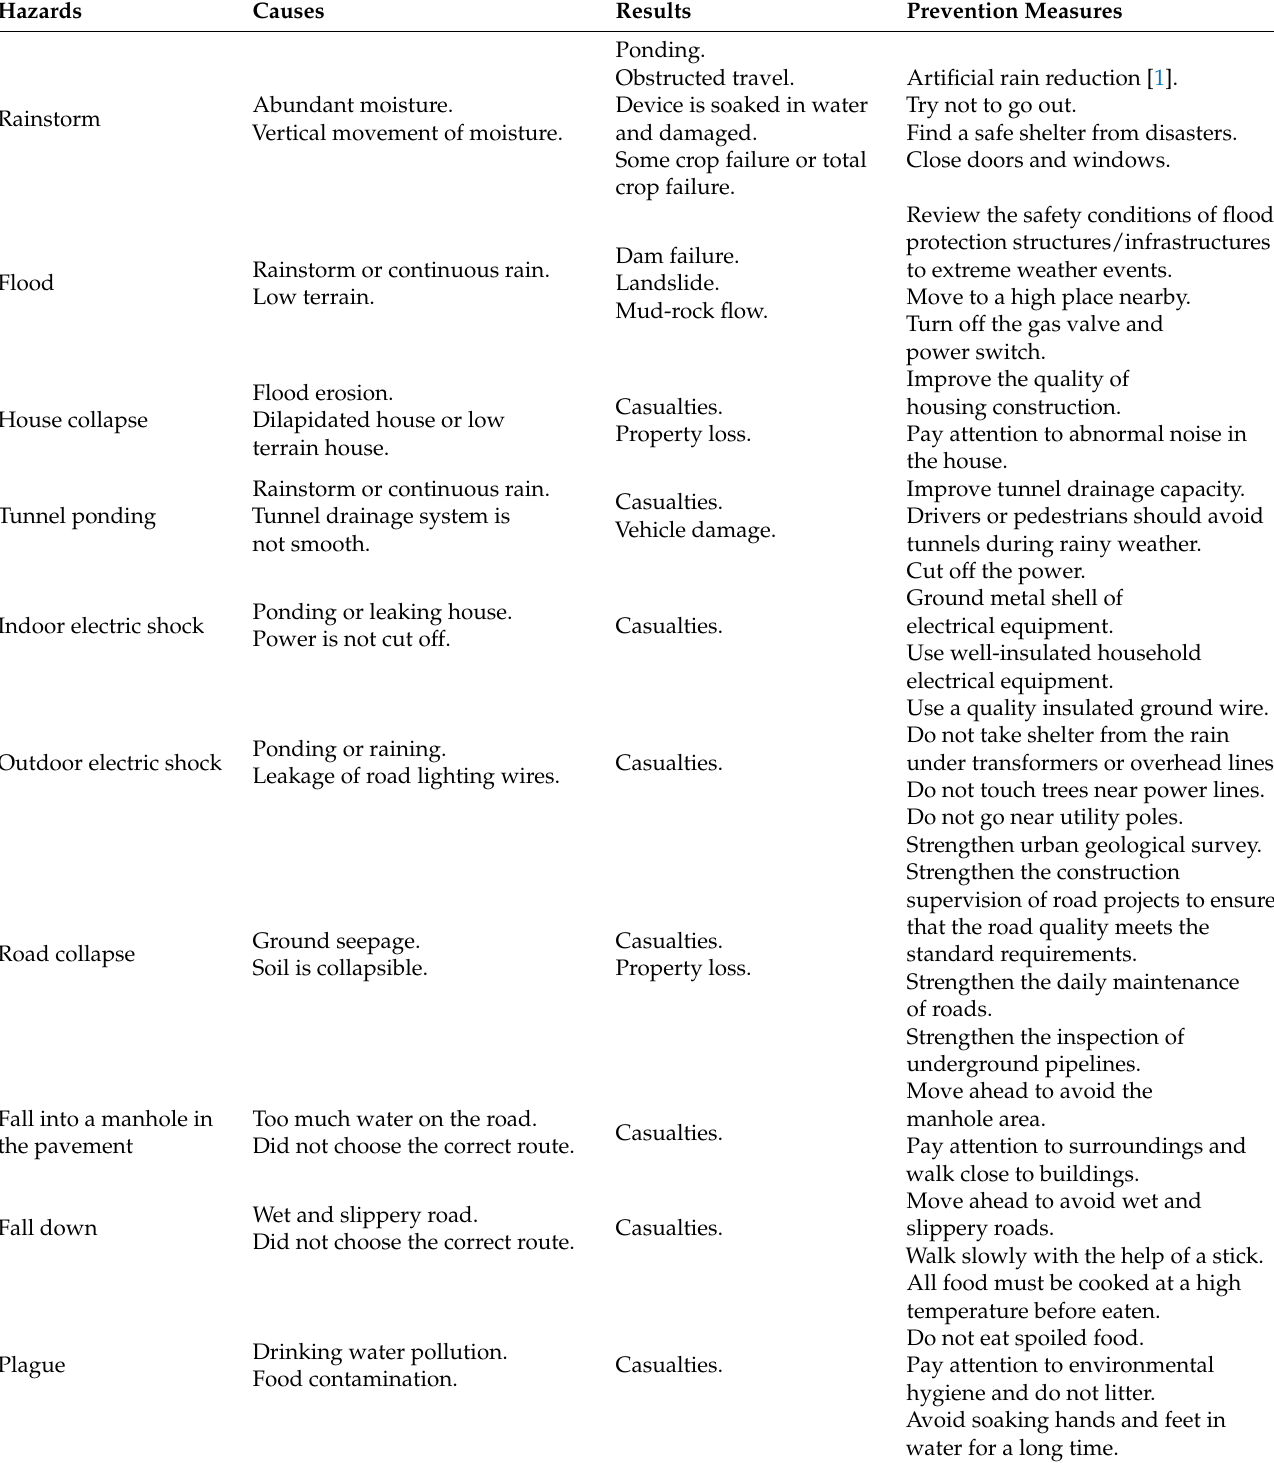
Table 2. PHA of hazards caused by